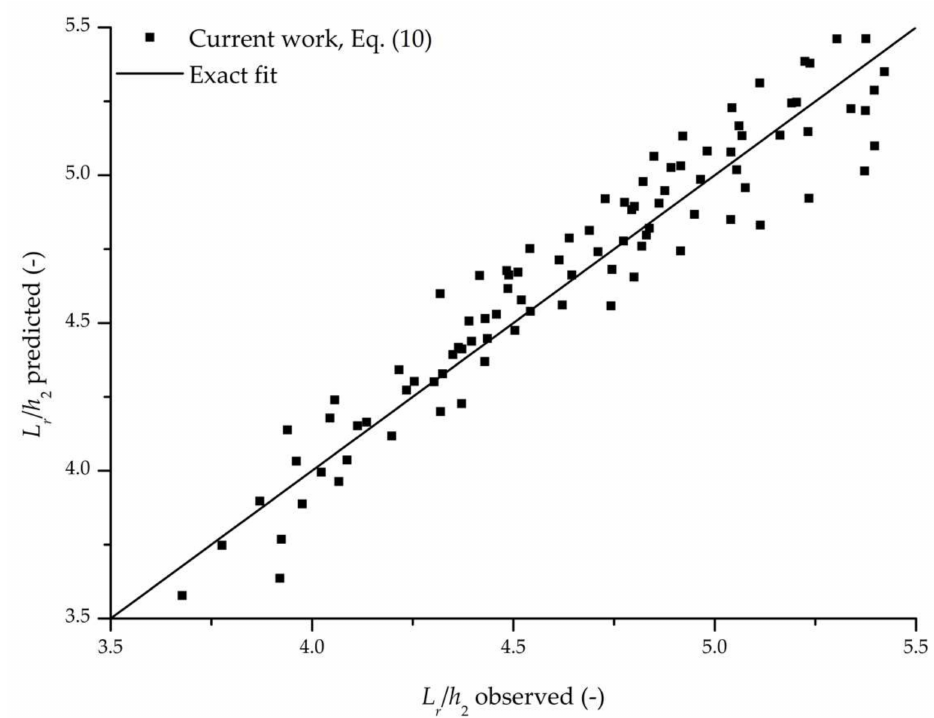
Figure 6. Observed vs. predicted roller lengths, relative to h 2 .